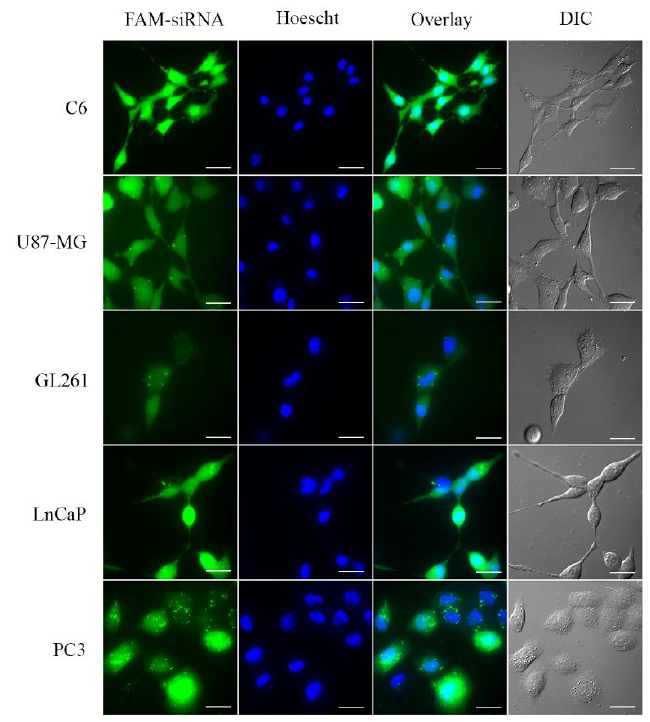
Figure 3. FAM-siRNA cellular uptake in C6, U87, GL261, LNCaP, and PC3 cell lines. AMC11 is capable of efficiently delivering FAM-siRNA into glioblastoma and PC cell lines after 6 or 8 h of incubation. The figure shows representative images of FAM-siRNA, Hoechst 33343 staining the nuclei, overlay of FAM-siRNA, and differential interference contrast microscopy (DIC) image. Scale bar: 25 µ